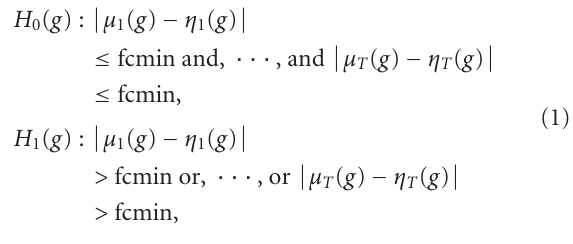
Figure 2: Three-dimensional multicriteria space for knockout and wild-type profiles over three-time points shown in Figure 1. The three criteria are the di ff erential probe responses at each time point. A scatter plot of sample means of the di ff erential responses along with a box of edge length 2fcmin distinguishing biologically sig- nificant responses (outside box) from biologically insignificant re- sponses (inside box) is